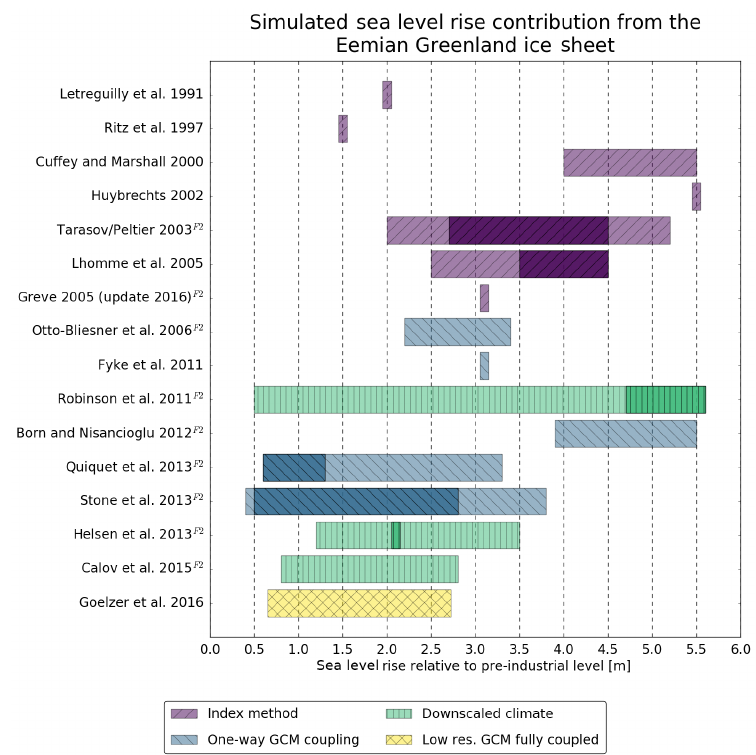
Figure 1. Overview of previously published GrIS contributions to the Eemian sea level high stand. The studies are color coded according to the atmospheric forcing used. More likely values are indicated with darker colors if provided in the respective studies. Different conversions from melted ice volume to sea level rise are used, and therefore the contributions are transformed to a common conversion if sufficient data (i.e., the pre-industrial ice volume for the respective simulations) are available. Due to this conversion, some of the values in this figure are slightly different from the original publications. We use a simple uniform distribution of the water volume on a spherical Earth. The common sea level rise conversion is performed for Greve (2005), Robinson et al. (2011), Born and Nisancioglu (2012), Quiquet et al. (2013), Helsen et al. (2013), and Calov et al. (2015). The minimum ice extent and topography of studies marked with “F2” are shown in Fig.